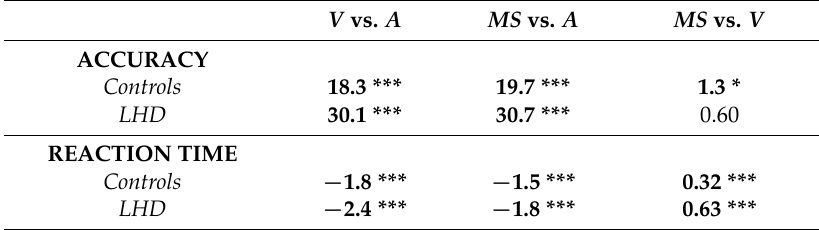
Table 4. Mean differences for naming accuracy and correct reaction time across